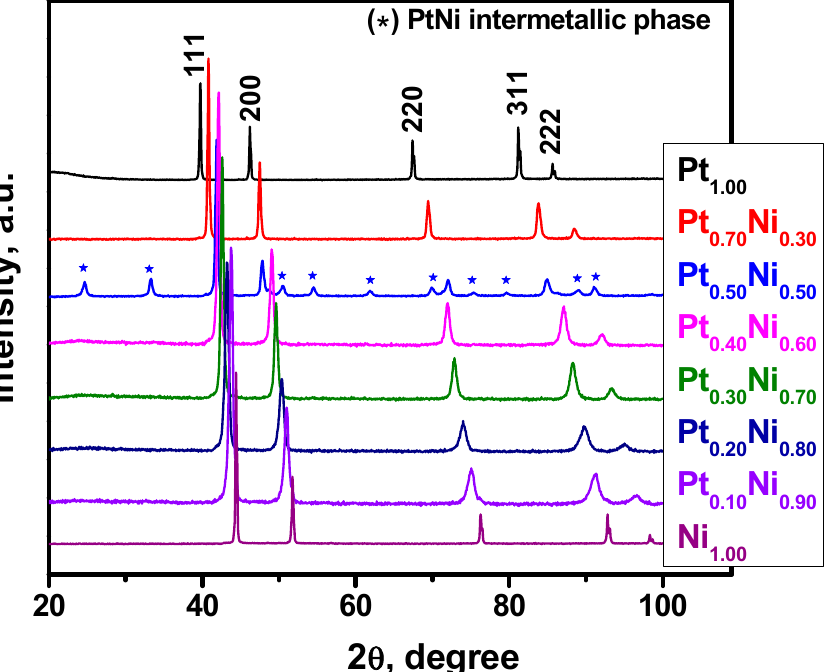
Figure 1. XRD patterns of pure Ni and Pt samples and Pt 1 − x Ni x (x = 0.30–0.90) alloys. Asterisks (*) show the superstructural reflections of the PtNi intermetallic phase.